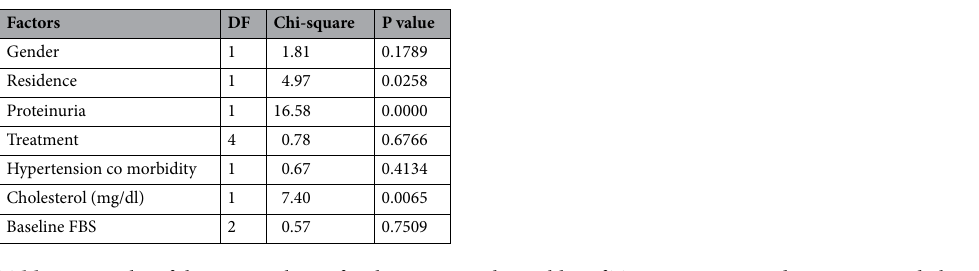
Table 2. Results of the Log-rank test for the categorical variables of T2DM patients under anti type 2 diabetes drugs in FHRH, December 2011–March 2016.